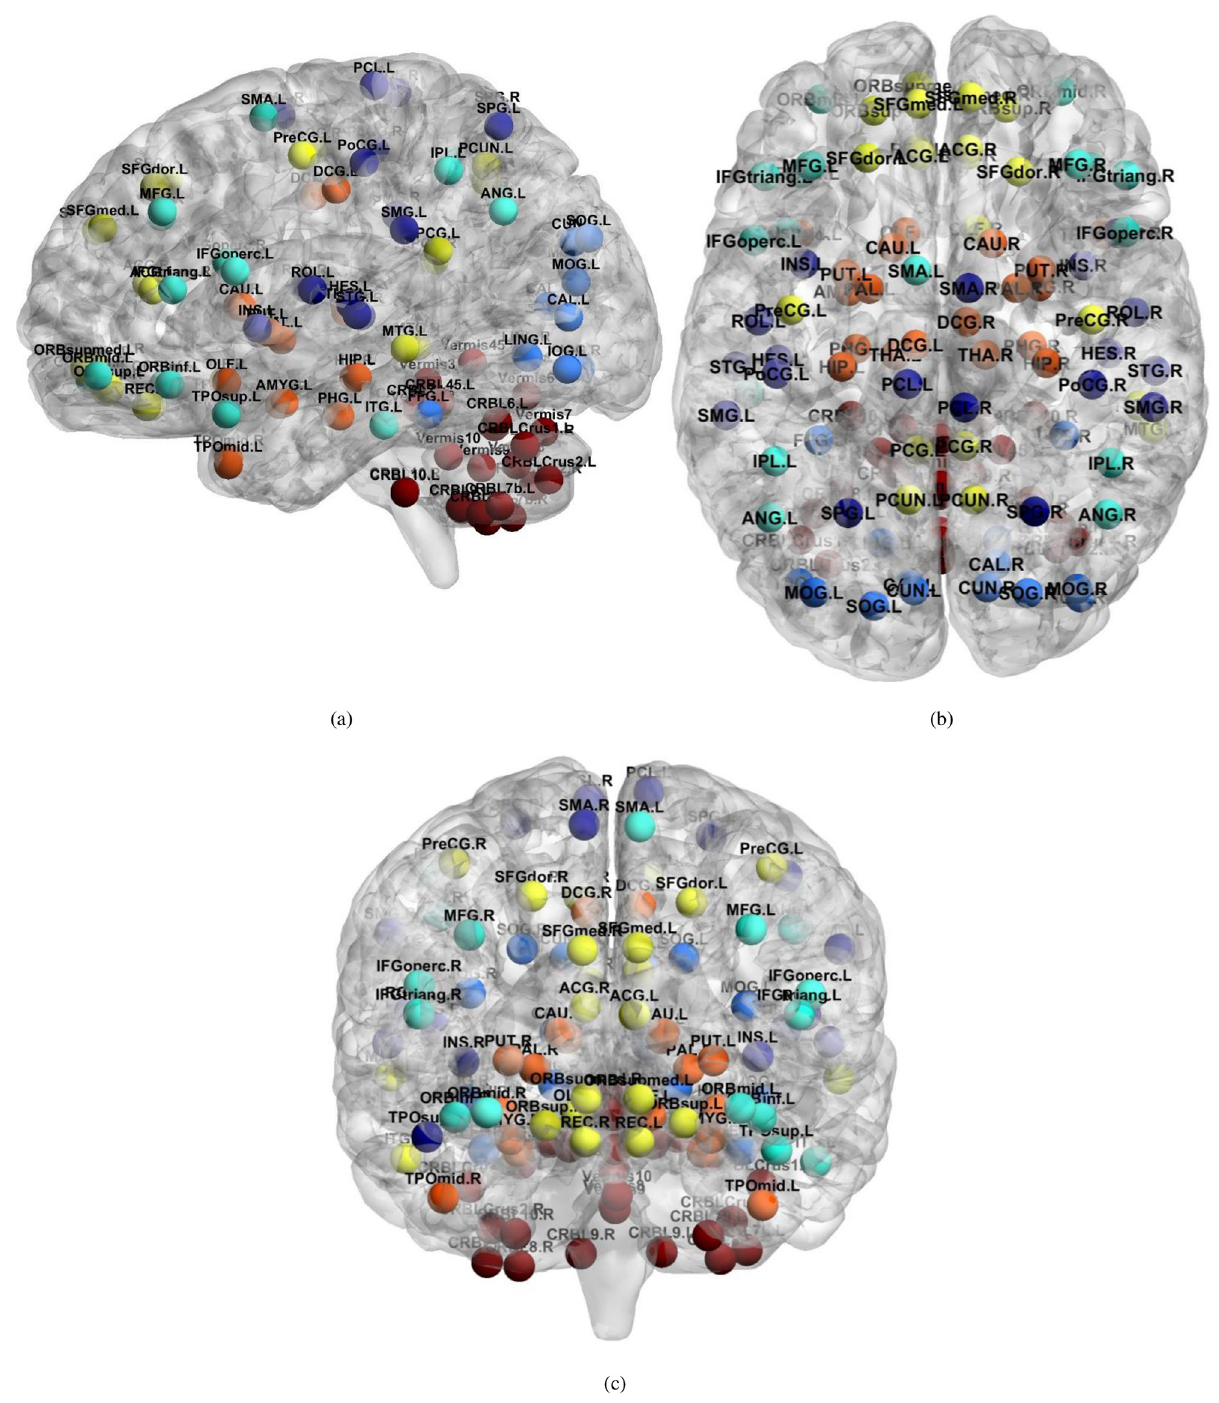
Fig 6. Localization of brain regions that have significant change in connections’ strength in case of AD compared to NC subjects AD, (a) Sagittal view, (b) Axial view, and (d) Coronal view. yellow: default-mode network; orange: regions of the subcortical nuclei; dark blue: regions of the sensorimotor cortex; blue: regions of the visual cortex; cyan: regions involved in the executive attention network; red: regions in the cerebellum.